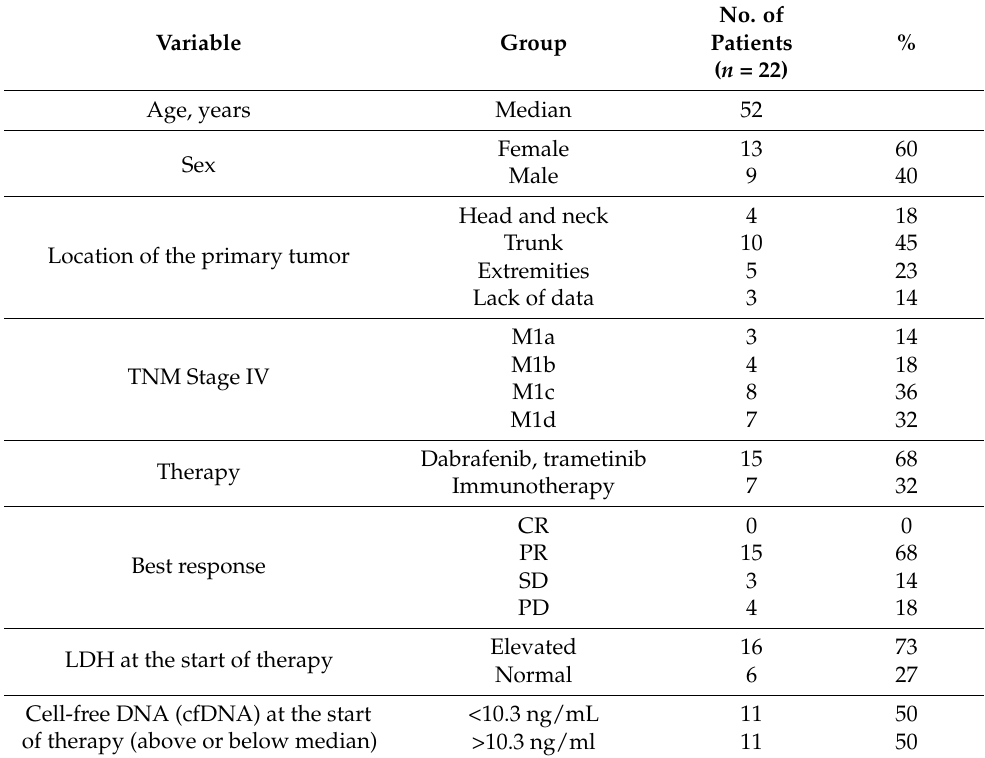
Table 1. Characteristics of the